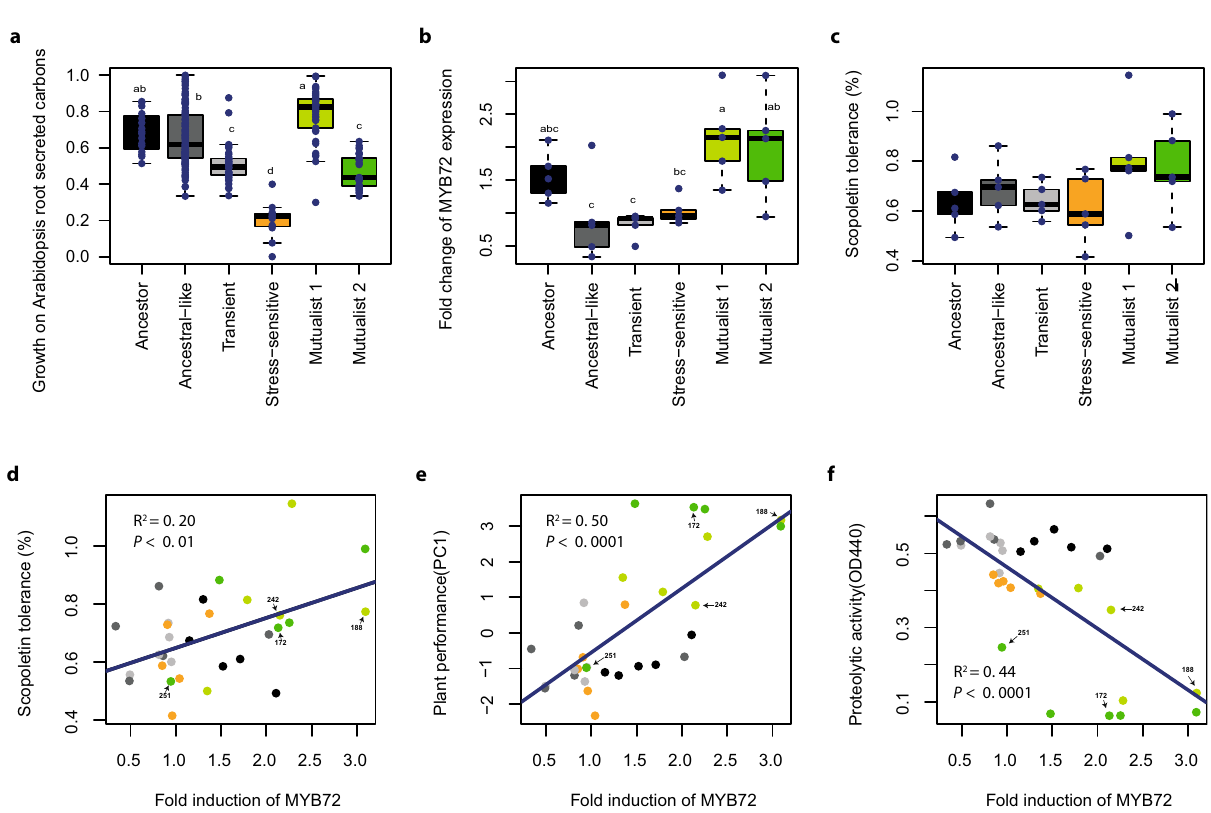
Fig. 3 Selection mechanisms favouring the increase in the relative abundance of mutualists in the rhizosphere of Arabidopsis thaliana . Panel a shows the growth of ancestor and evolved Pseudomonas protegens CHA0 phenotypes on carbons typically secreted by A. thaliana (14 most dominant carbons analysed as a combined index based on normalised fi rst principal component PC1, which explained 83.9% of total variation). In total, 256 isolates were characterized including ancestral ( n = 16), ‘ Ancestral-like ’ ( n = 119), ‘ Transient ’ ( n = 41), ‘ Stress-sensitive ’ ( n = 11), ‘ Mutualist 1 ’ (37), and ‘ Mutualist 2 ’ ( n = 31) phenotypes. Panel b shows the effect of ancestor and evolved P. protegens CHA0 phenotypes on the expression of MYB72 (transcription factor responsible for scopoletin production) in the roots of a GUS A . thaliana reporter line (based on the quanti fi cation of GUS staining of the roots, Fig. S6). Panel c shows the relative growth of ancestor and evolved P. protegens CHA0 phenotypes in the presence of the plant-secreted scopoletin antimicrobial at 2 mM concentration after 72 h of incubation relative to no-scopoletin control. Panel d shows a positive relationship between MYB72 expression (fold induction; x -axis) and scopoletin tolerance ( y- axis) for all tested isolates. Panel e shows a positive relationship between MYB72 expression (fold induction; x -axis) and plant performance ( y -axis) for all tested isolates. Panel f shows a negative relationship between MYB72 expression (fold induction; x -axis) and proteolytic activity ( y -axis) for all tested isolates. The sample IDs of four isolates from the two mutualistic phenotype groups are highlighted on labels (see Table S2) in panels d – f . Panels b – f include fi ve representative bacterial isolates ( n = 5, biologically independent isolates) from each phenotype in addition to the ancestor (each replicate line represented; see Table S2). In all panels, bacterial phenotype groups are displayed on different colours (black: ancestor; dark grey: ancestral-like; light grey: transient; orange: stress-sensitive, light green: Mutualist 1 and dark green: Mutualist 2). All boxplots show median (centre line), interquartile range (25 – 75%) and whiskers that extended 1.5 times the interquartile range overlaid with a scatter plot showing independent replicates. Statistical testing in panels a – c was carried out using one-way ANOVA followed by Tukey ’ s multiple comparison test ( α = 0.05; different lowercase letters indicate signi fi cant differences). Panels d – f show linear regression (black line) and Pearson correlations fi tted over all biologically independent isolates ( n = 30). Data for all panels are provided in the Source Data fi